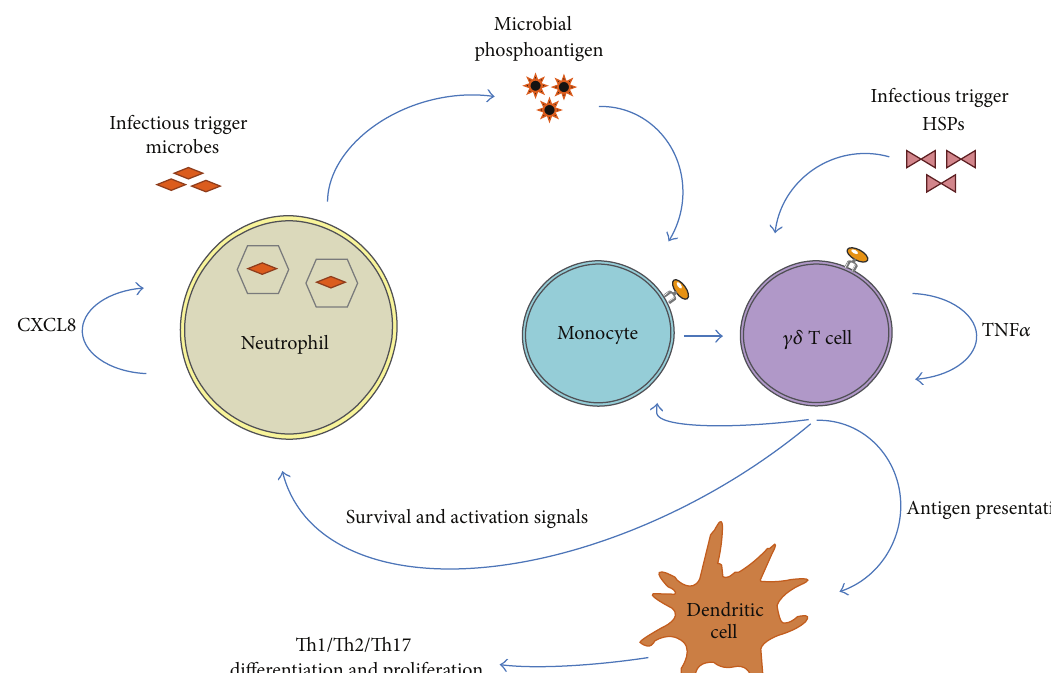
Figure 1: Schematic diagram of the potential interaction of neutrophils, monocytes, and DCs with 𝛾𝛿 T cells in BD. An infectious trigger (e.g., microbes) results in extravasation of neutrophils and following phagocytosis of the invading microbes, neutrophils release traces of HMB-PP into the microenvironment where 𝛾𝛿 T cells sense it. Monocytes then might take up or bind this soluble HMB-PP and present it to 𝛾𝛿 T cells. This interaction triggers TNF 𝛼 secretion, a proinflammatory cytokine along with other similar cytokines including IFN 𝛾 which promotes 𝛾𝛿 T cell expansion and drive local chemokine (CXCL8) production that further recruits new neutrophils and monocytes to the site of infection. In addition, activated 𝛾𝛿 T cells keep providing survival and activation signals to the newly recruited neutrophils and monocytes by secreting TNF 𝛼 . Furthermore, activated 𝛾𝛿 T cells present antigen to DCs and thus initiate Th1, Th2, and Th17 differentiation and proliferation. Even if the infectious trigger is in the form of a non-HMB-PP source such as HSP60/65, 𝛾𝛿 T cells can again respond by expanding and keep the interaction active with the neighbouring